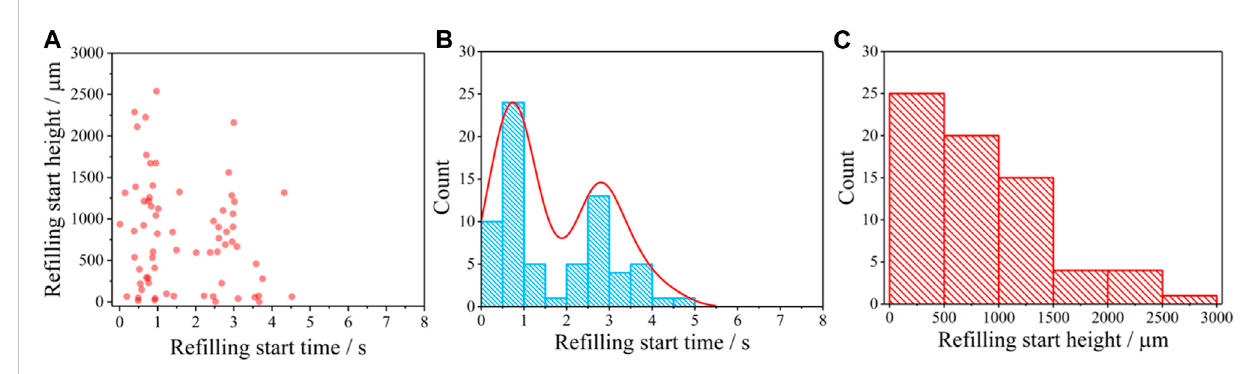
FIGURE 2 Startup time and height of water re fi lling in vessels. (A) Height vs. time. (B) Histogram of startup time and (C) Histogram of startup